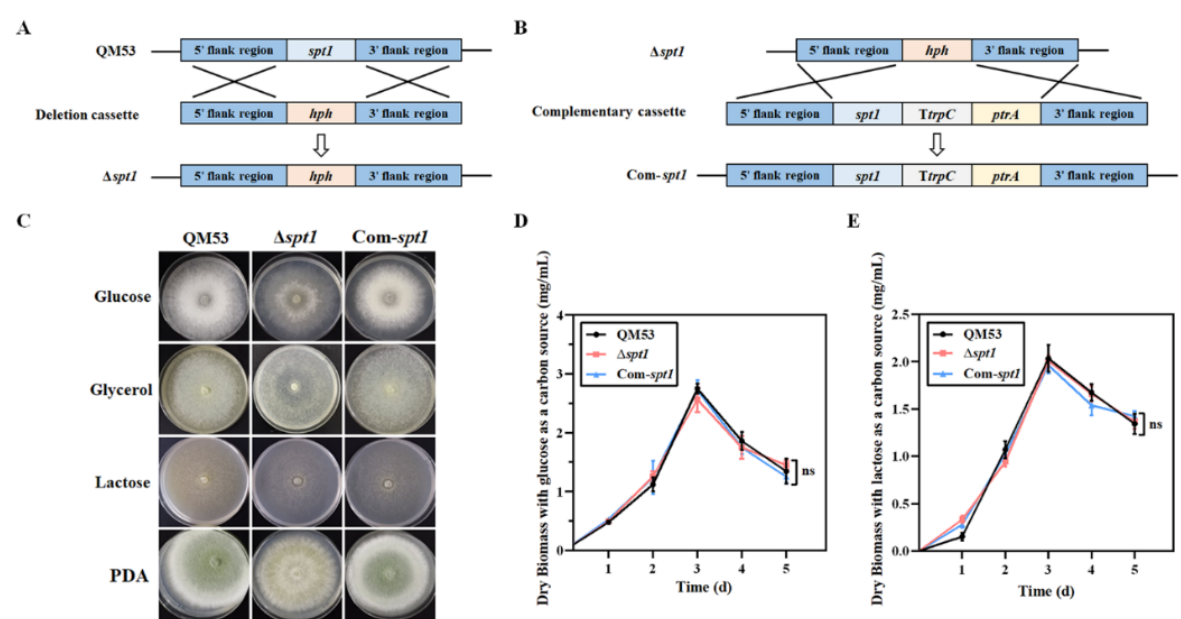
Figure 2. Construction of the spt1 deletion strain Δ spt1 and the spt1 complementation strain Com- spt1 . ( A ) Schematic diagram of the spt1 deletion cassette. The cassette was inserted into the